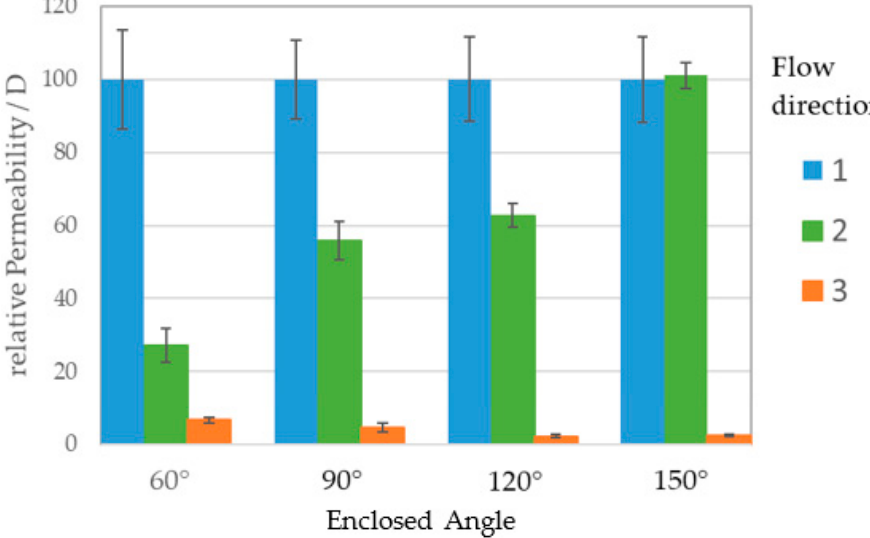
Figure 13. Flow ratio normalized to unhindered flow. With increasing tilt angle α the ratio of direction 2 (green) to 1 (blue) in rises from 0.25 up to 1.